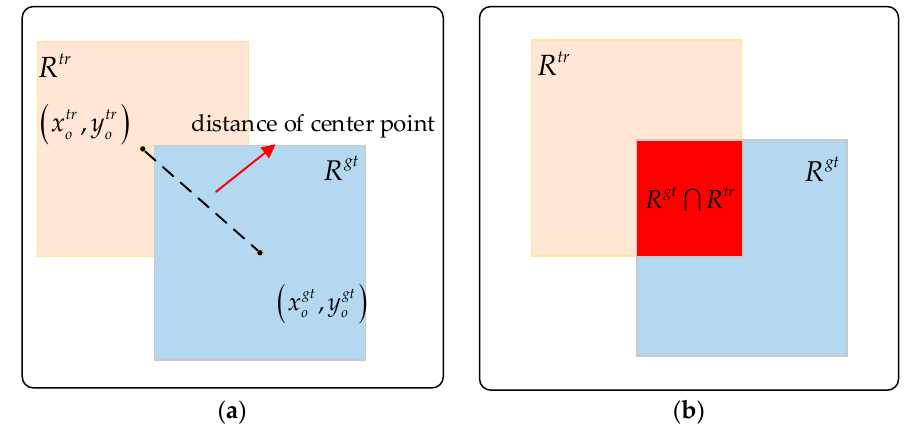
Figure 6. Evaluation criterion. ( a ) Distance of the center point. ( b ) Intersection over the union.